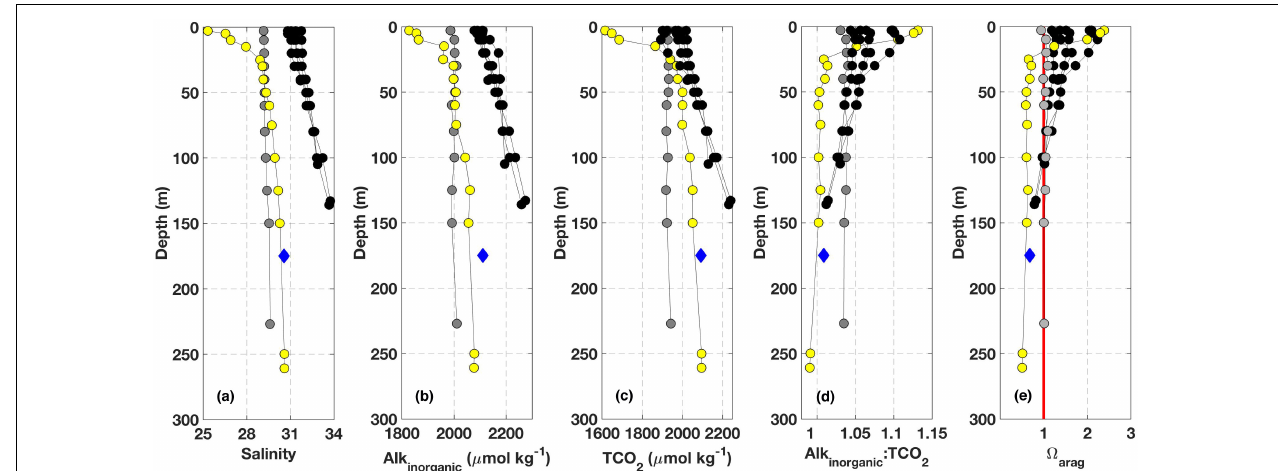
salinity, Alk inorganic , TCO 2 , Alk inorganic :TCO 2 , and (cid:127) arag were 30.58 ± 0.25, 2112 ± 24 µ mol kg − 1 , 2093 ± 31 µ mol kg − 1 , 1.009 ± 0.008, and 0.68 ± 0.09,